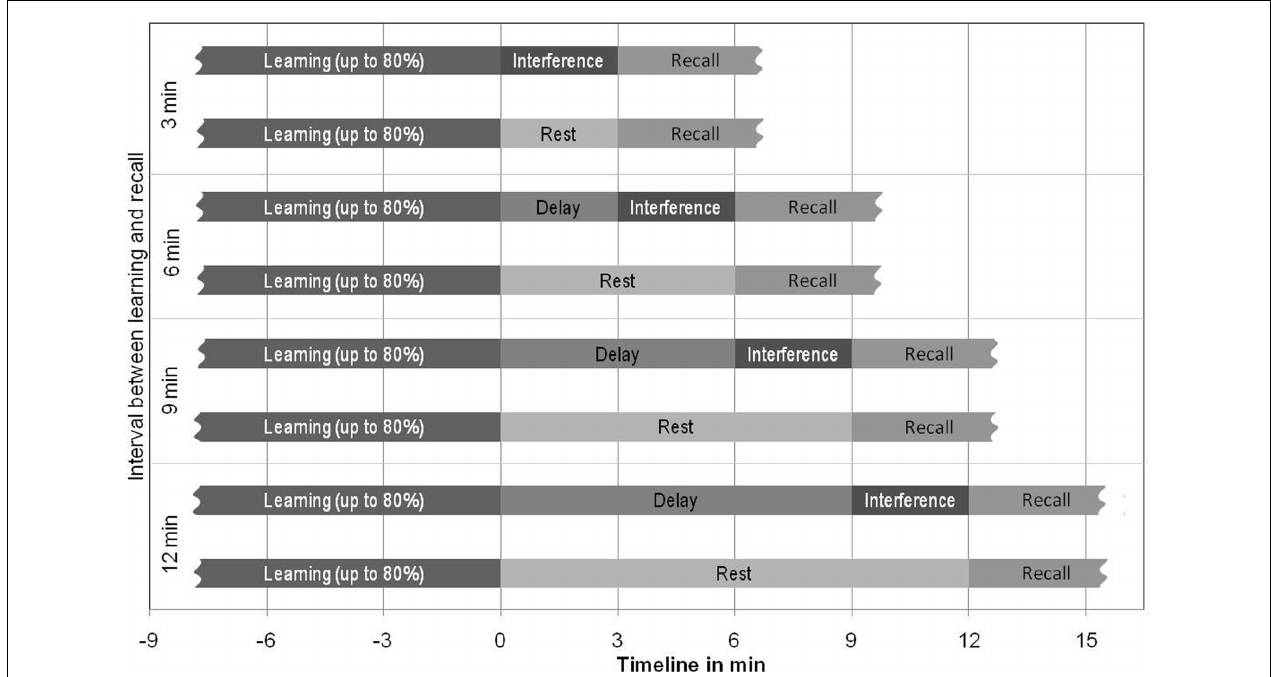
FIGURE 1 | Paired-associate vocabulary learning paradigm. During the initial learning period (black regions on the left) participants learned twelve German–Japanese vocabulary pairs in each of the 2 × 6 = 12 experimental conditions until 80% recall performance. In separate experiments participants either performed an additional vocabulary-learning unit with 12 new word pairs (interference experiment) or they closed their eyes and relaxed (control experiment) during the subsequent retention interval (intermediate light and dark gray regions). Retention interval durations differed between experimental conditions. At the end of the retention intervals participants performed a cued recall test (dark gray regions on the right), where the German words from the initial learning period were presented and the Japanese words had to be recalled. The interference and control experiments were performed in a within-group design with the order of presentation counterbalanced between